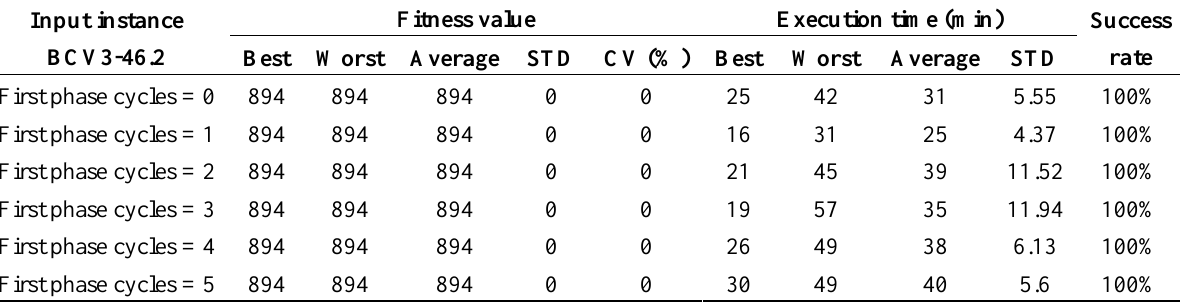
Table 8. Investigating the effect of first phase’s number of cycles for input instance,